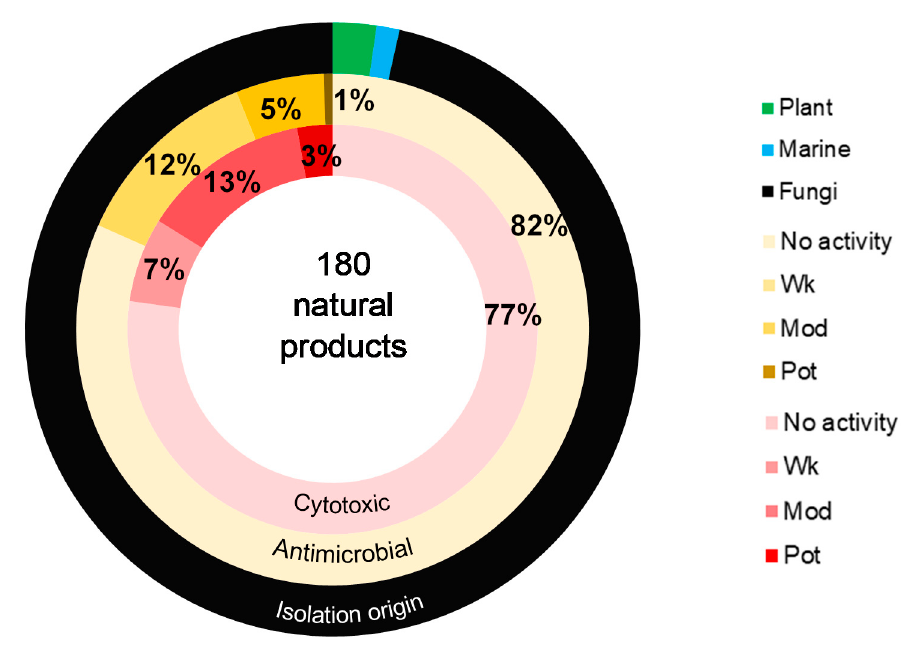
Figure 30. Summary of protoilludanes isolated to date with their bioactivity.